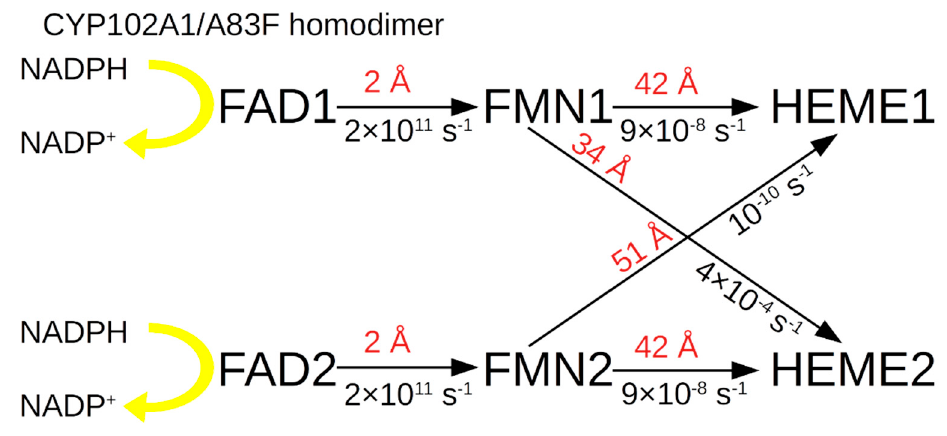
Figure 7. Scheme of electron transport in the electron transport chain of the homodimer in CYP102A1/A83F.